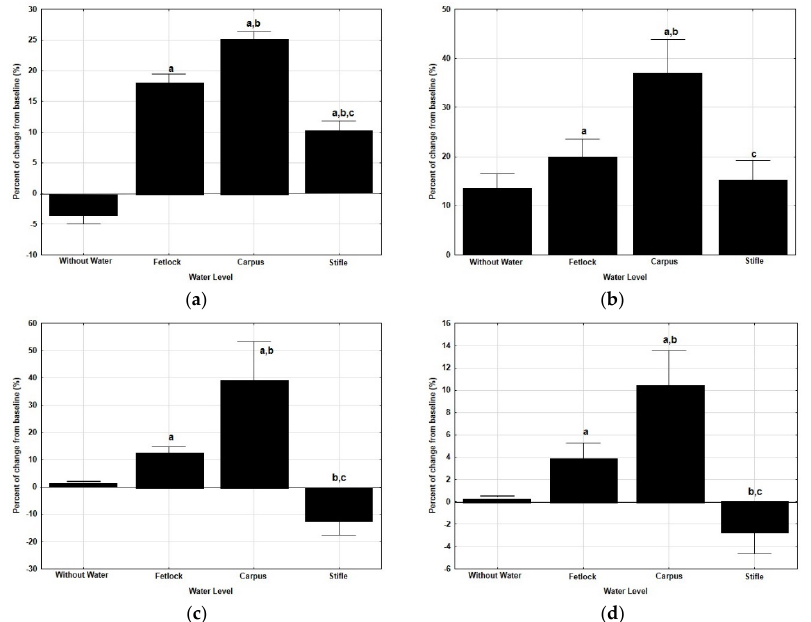
Figure 2. Median and quartiles of the percent of change from baseline of the total accelerometric activity, measured on a track after WT exercise sessions at four different water depths, at walk and at trot and with the accelerometer in two different positions (PECT, in the pectoral region; SML, in the sacrum midline) (( a ): at walk with the accelerometer in PECT position; ( b ): at trot with the accelerometer in PECT position; ( c ): at walk with the accelerometer in SML position; ( d ): at